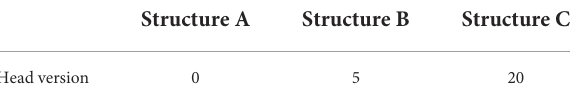
TABLE 1 Result of querying an imaginary database with the semiology term Head version and exemplar brain structures A, B, and C, assuming that the brain has been parcellated into only three